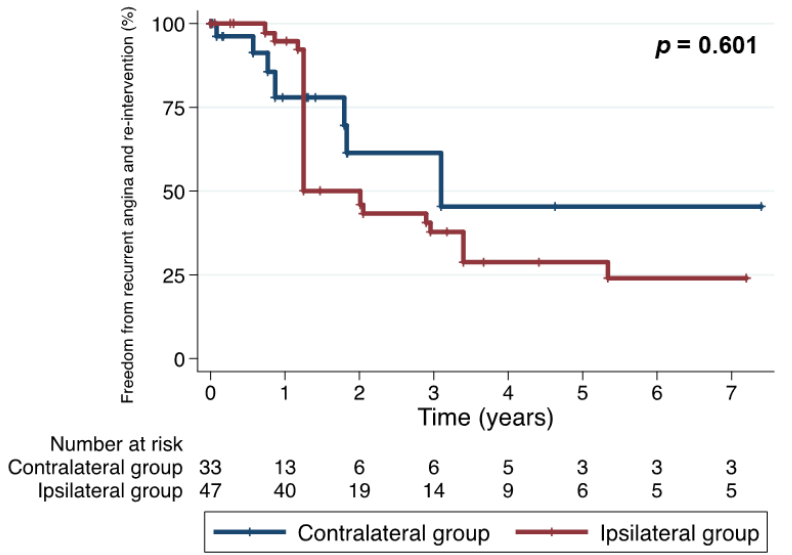
Figure 3. Freedom from major adverse cardiovascular and cerebrovascular events (inverse proba- bility weighting-adjusted comparison).